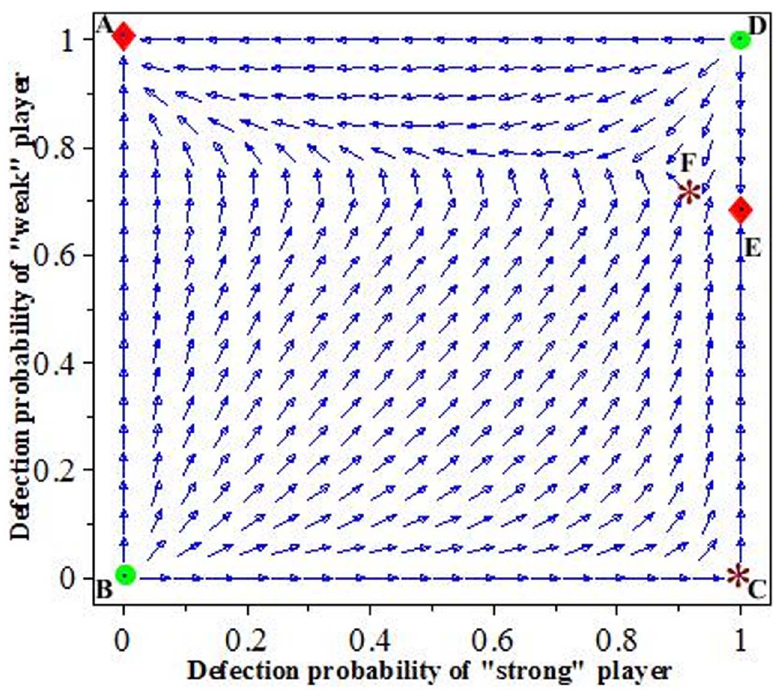
Figure 1. The slope field for replicator dynamics of the asymmetric volunteer’s dilemma. Sink points A (0,1) and E (1, b (cid:3) equilibrium solutions (red diamonds), and source points B , D (green circles) and saddle points C , F (purple red stars) are unstable equilibrium solutions. The parameters are fixed at K S ~ 0 : 15, K W ~ 0 : 2, U S ~ 1, U W ~ 1 and N ~ 7 .